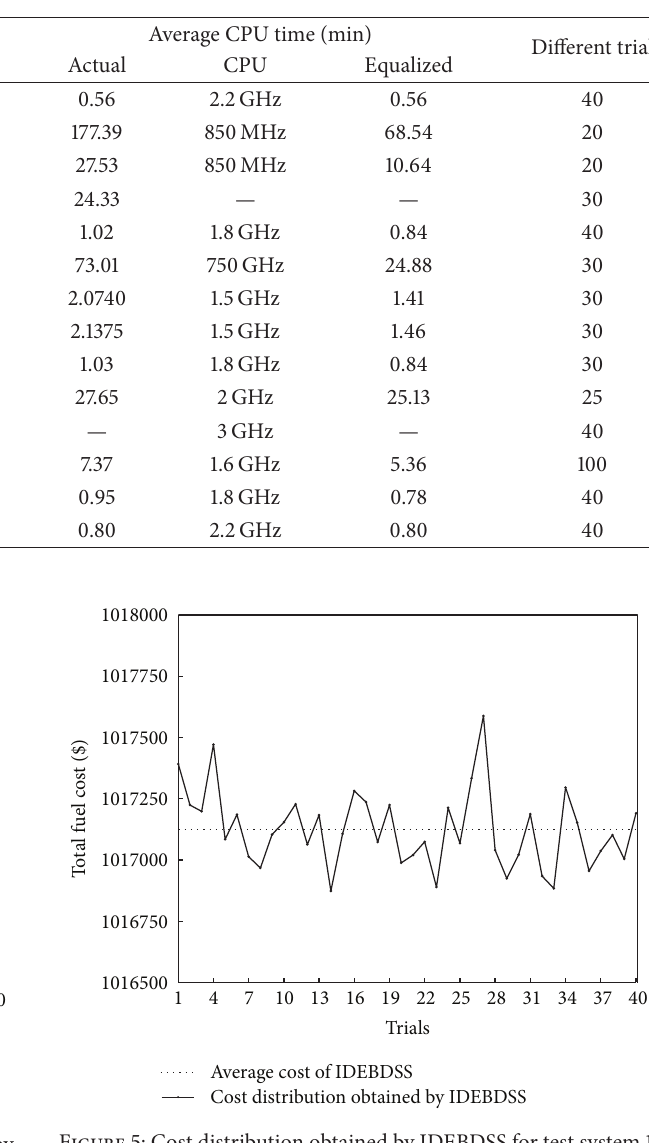
Table 6: Comparison of results with different methods for test system 3.